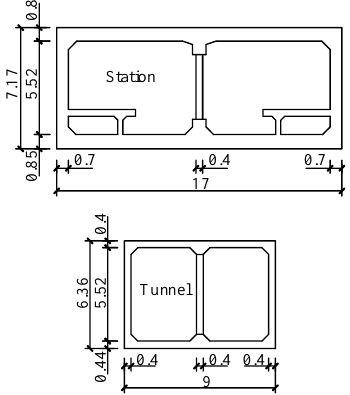
Figure 2. Cross-section of Daikai station and subway tunnel (unit: m). The cross-sectional reinforcement of the central columns in Daikai station and the tunnel are shown in Figure 3, and the longitudinal reinforcement ratios are comparable: 6% and 5.6%, respectively. After the earthquake, Daikai station was repaired, and the cen- tral columns were changed from the original reinforced concrete to the current combina- tion of three square concrete-filled steel tubes (CFSTs). The length and width of the steel tube are both 450 mm, and the thickness is 12 mm. It can be seen from Figure 3 that the cross-sectional size and reinforcement rate of the new central columns are larger than those in the original Daikai station. In addition, the cross-sectional dimensions and rein- forcement ratios of the structural components in the original Daikai station and the tunnel are shown in Table 1.